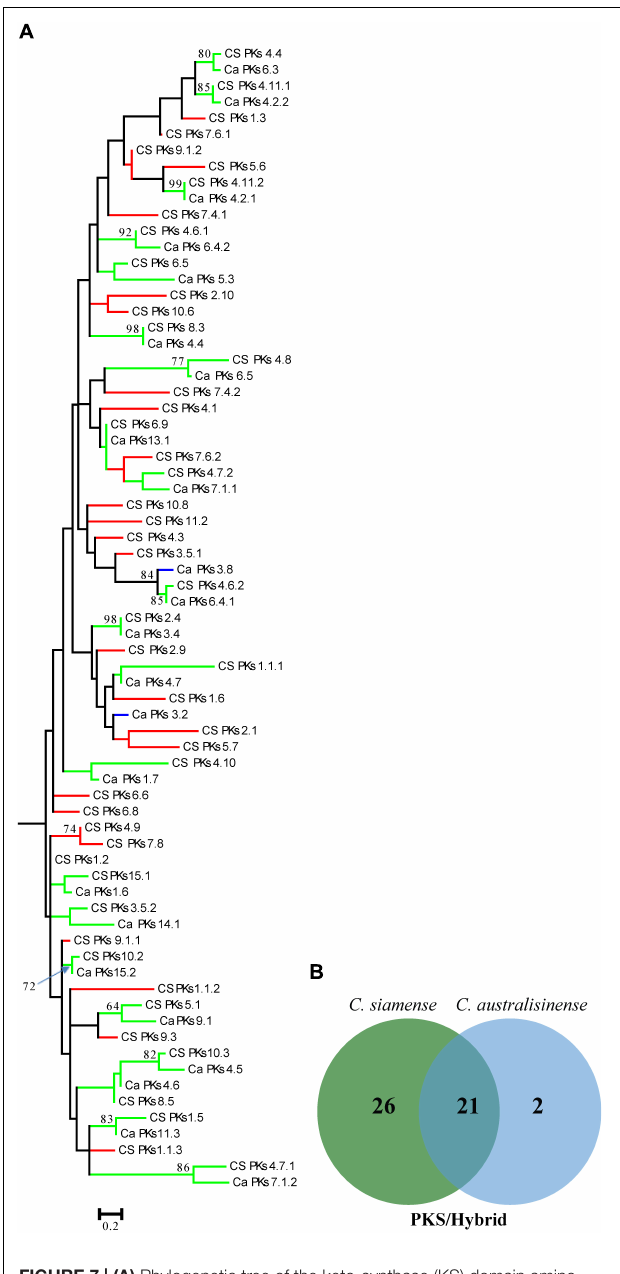
FIGURE 7 | (A) Phylogenetic tree of the keto-synthase (KS) domain amino acid sequences of putative PKSs and PKS-NRPS hybrids. Sequences were aligned using MEGA 6.0, and phylogenies inferred by maximum-likelihood (as calculated by the LG + G Model) in MEGA 6.0. The numbers on branch nodes indicate support values above 50%. Red branches show the KS of Colletotrichum siamense only; blue branches show the KS of C. australisinense only; green branches are the KS shared between both species. (B) Venn diagram summarizing the numbers of conserved and non-conserved sequences between the two fungal